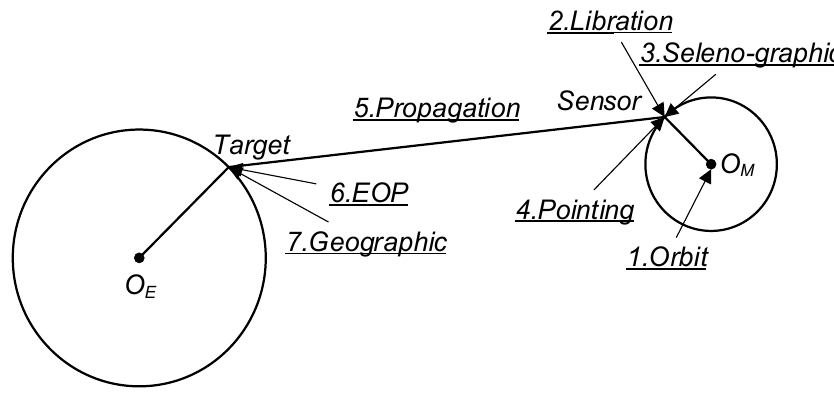
Figure 9. There are seven categories of error sources analyzed. The errors from aberration and light time have been corrected, and thus are not included. time have been corrected, and thus are not